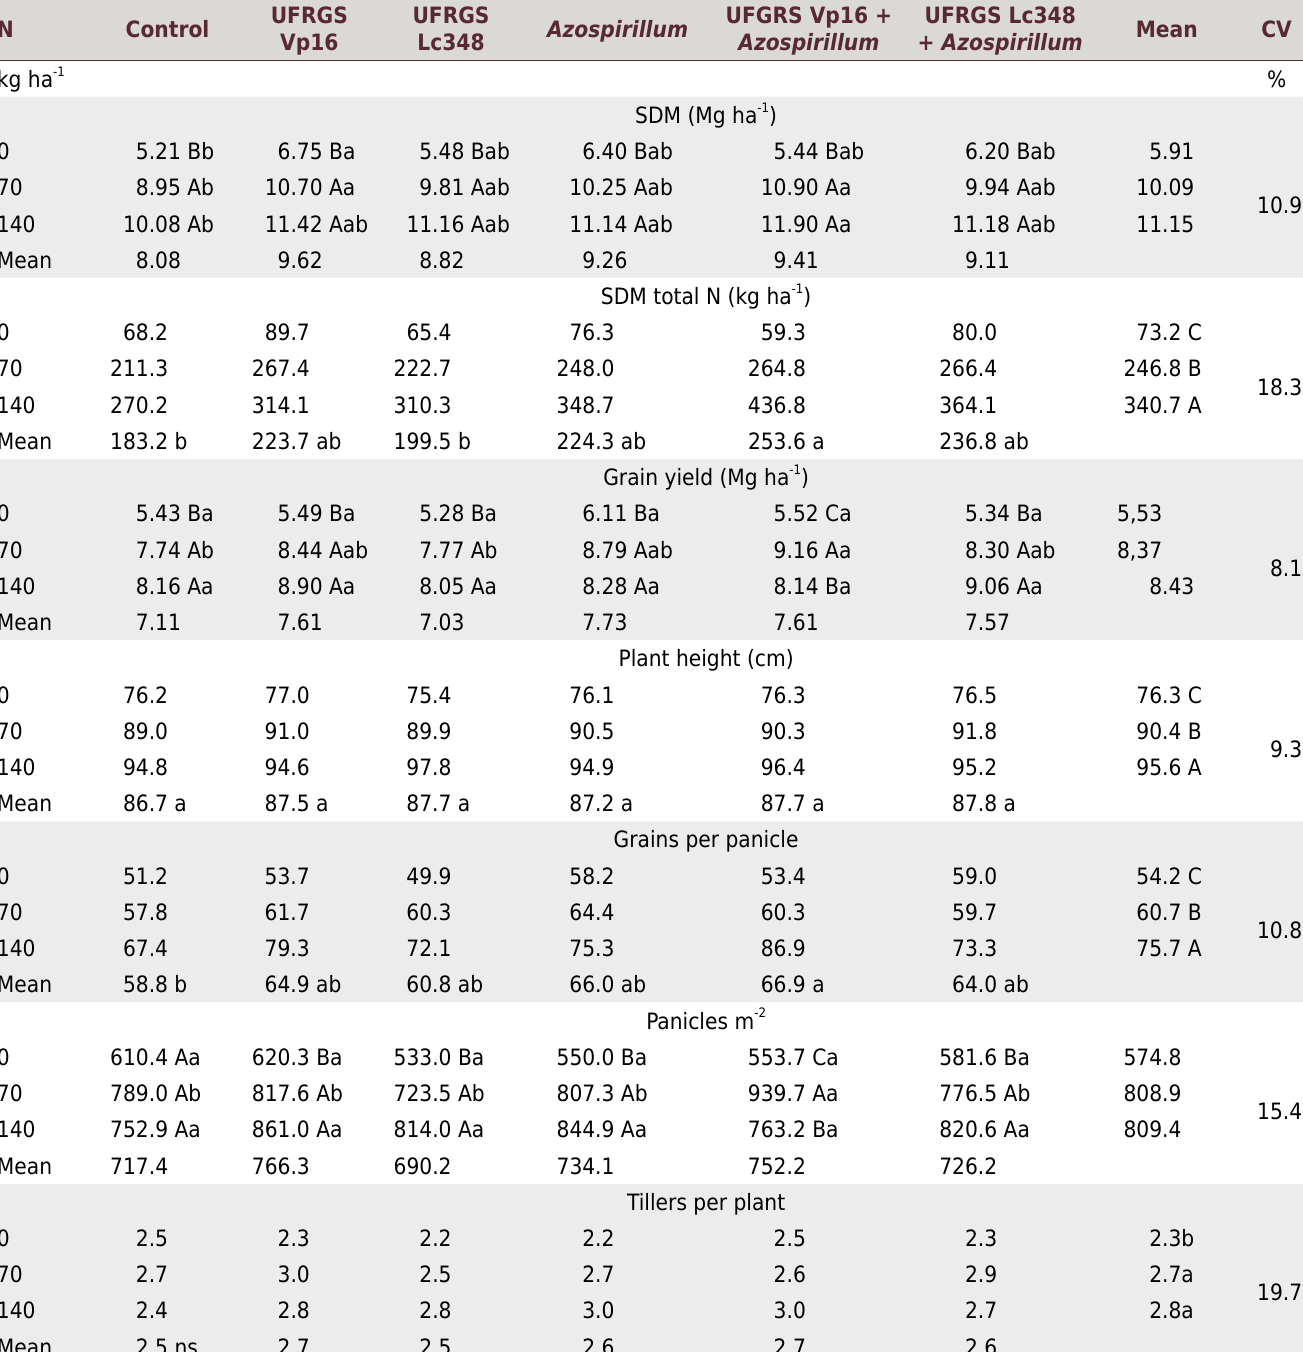
Table 4. Production of shoot dry matter (SDM), shoot dry matter total N (SDM total N), grain yield, plant height, grains per panicle, panicles m -2 , and tillers per plant of wetland rice cultivar IRGA 422CL inoculated with diazotrophic bacteria at 0, 70, and 140 kg ha